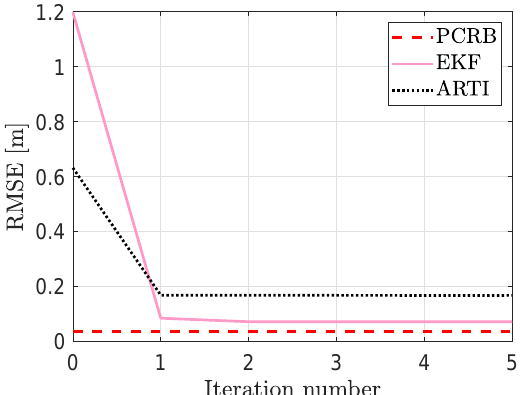
Figure 9. The posterior Cramér-Rao bound ( ) and RMSE of the proposed system ( ) and the benchmark system ( ). For every iteration number, the results are averaged over 100 Monte Carlo